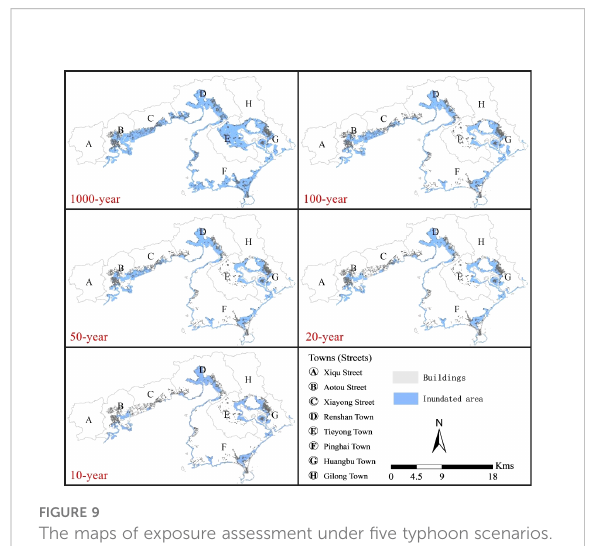
FIGURE 9 The maps of exposure assessment under fi ve typhoon scenarios. Different letters mean different name of towns or street in the study